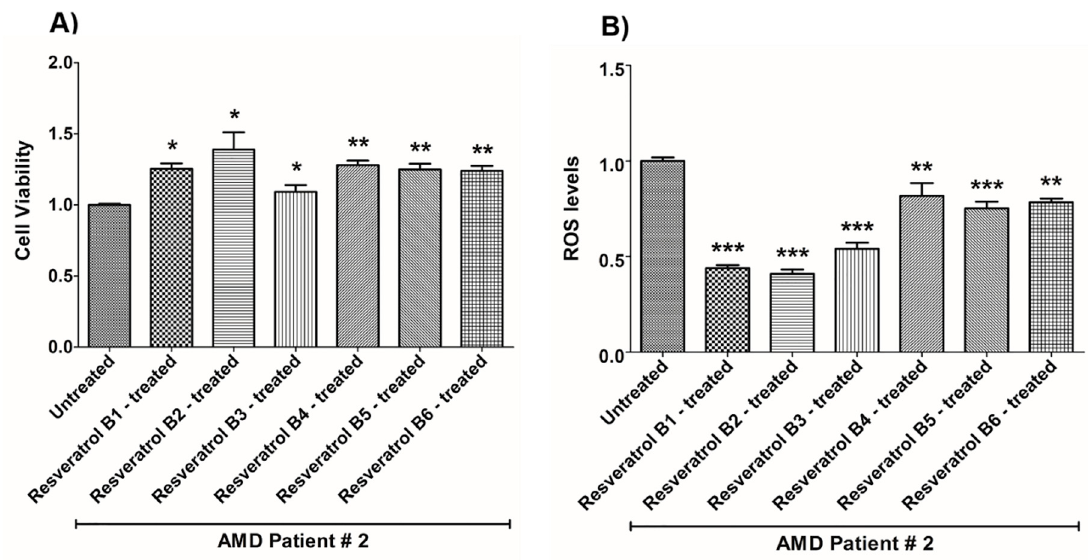
Figure 3. E ff ects of resveratrol formulations on cell viability ( A ) and ROS levels ( B ) in AMD patient #2.